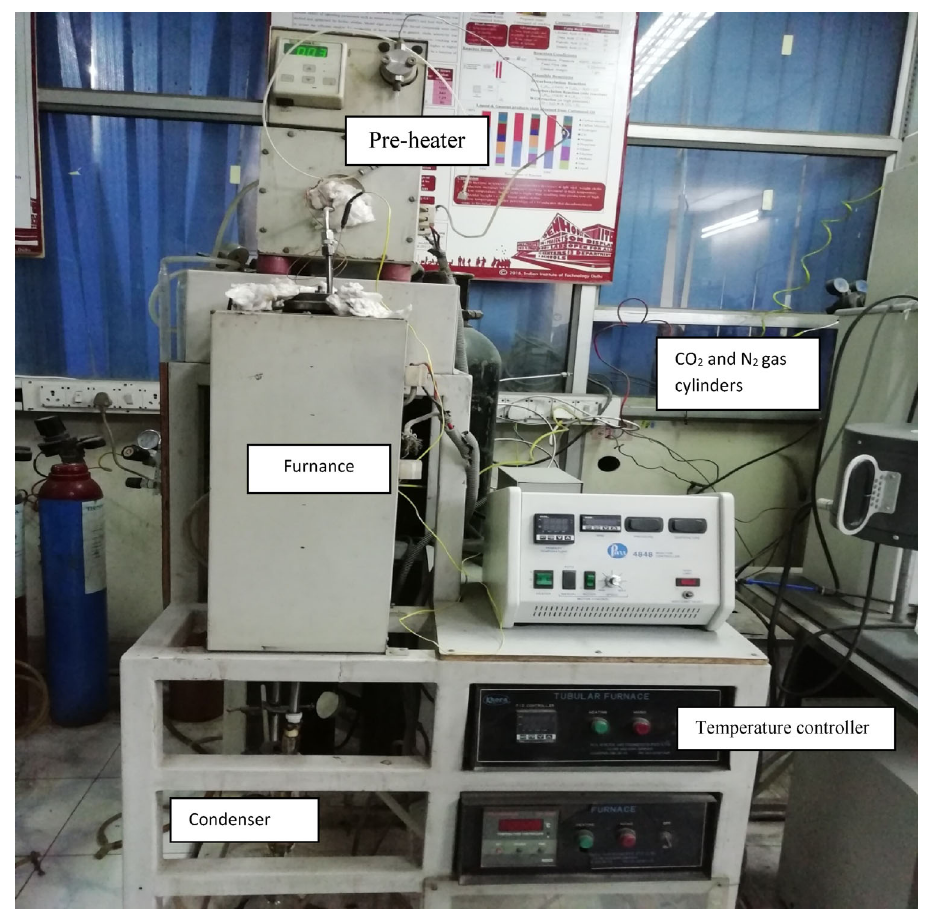
Fig. 1 Fixed bed reactor used for CO 2 -gasification